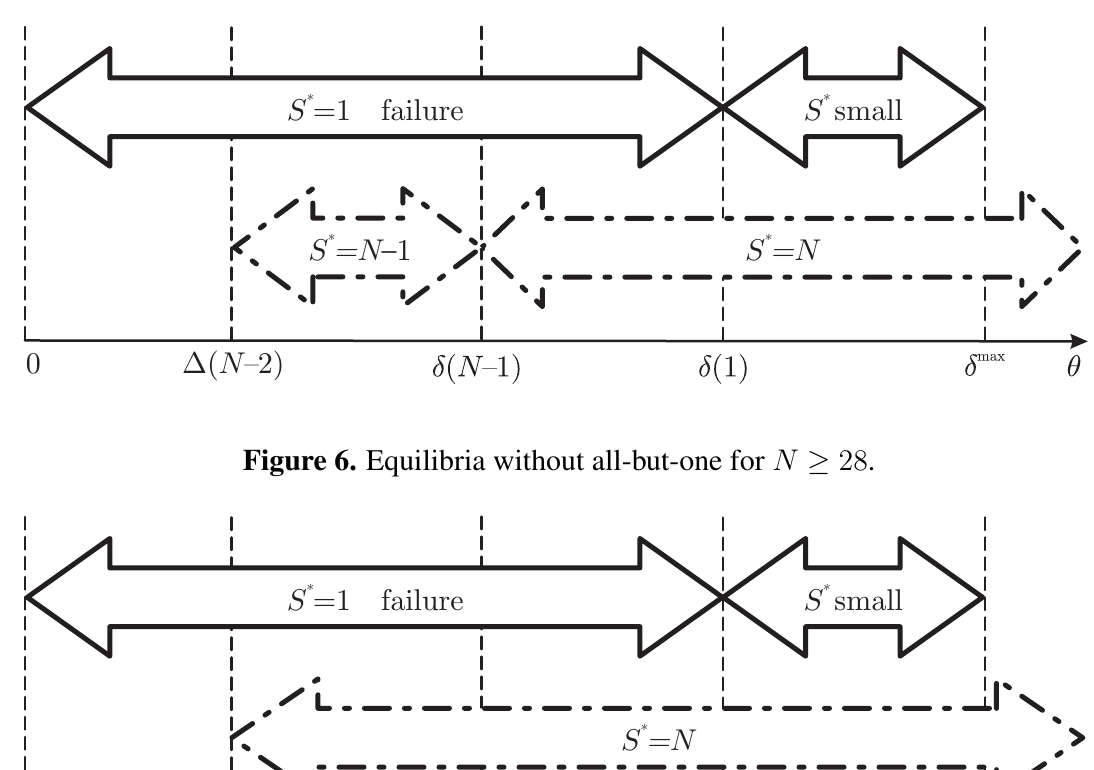
Figure 5. Equilibria with all-but-one for 12 ≤ N < 28.